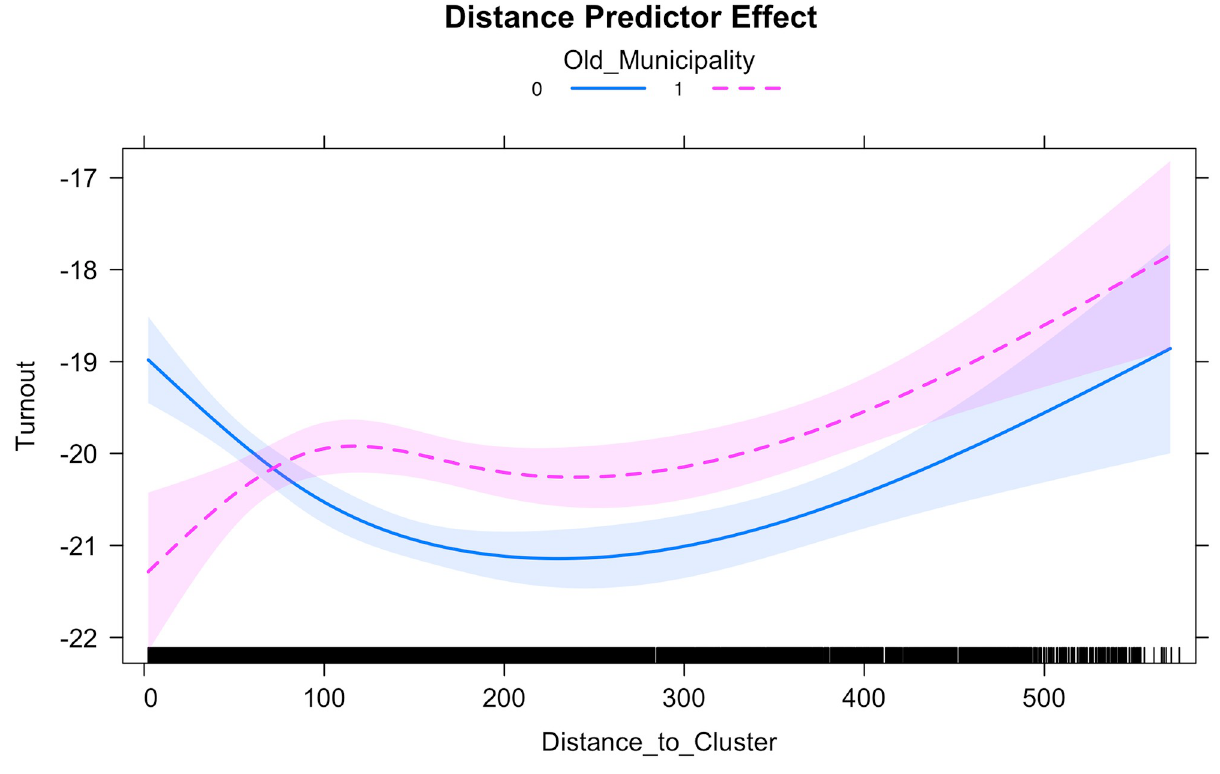
Fig 6. Spline regression